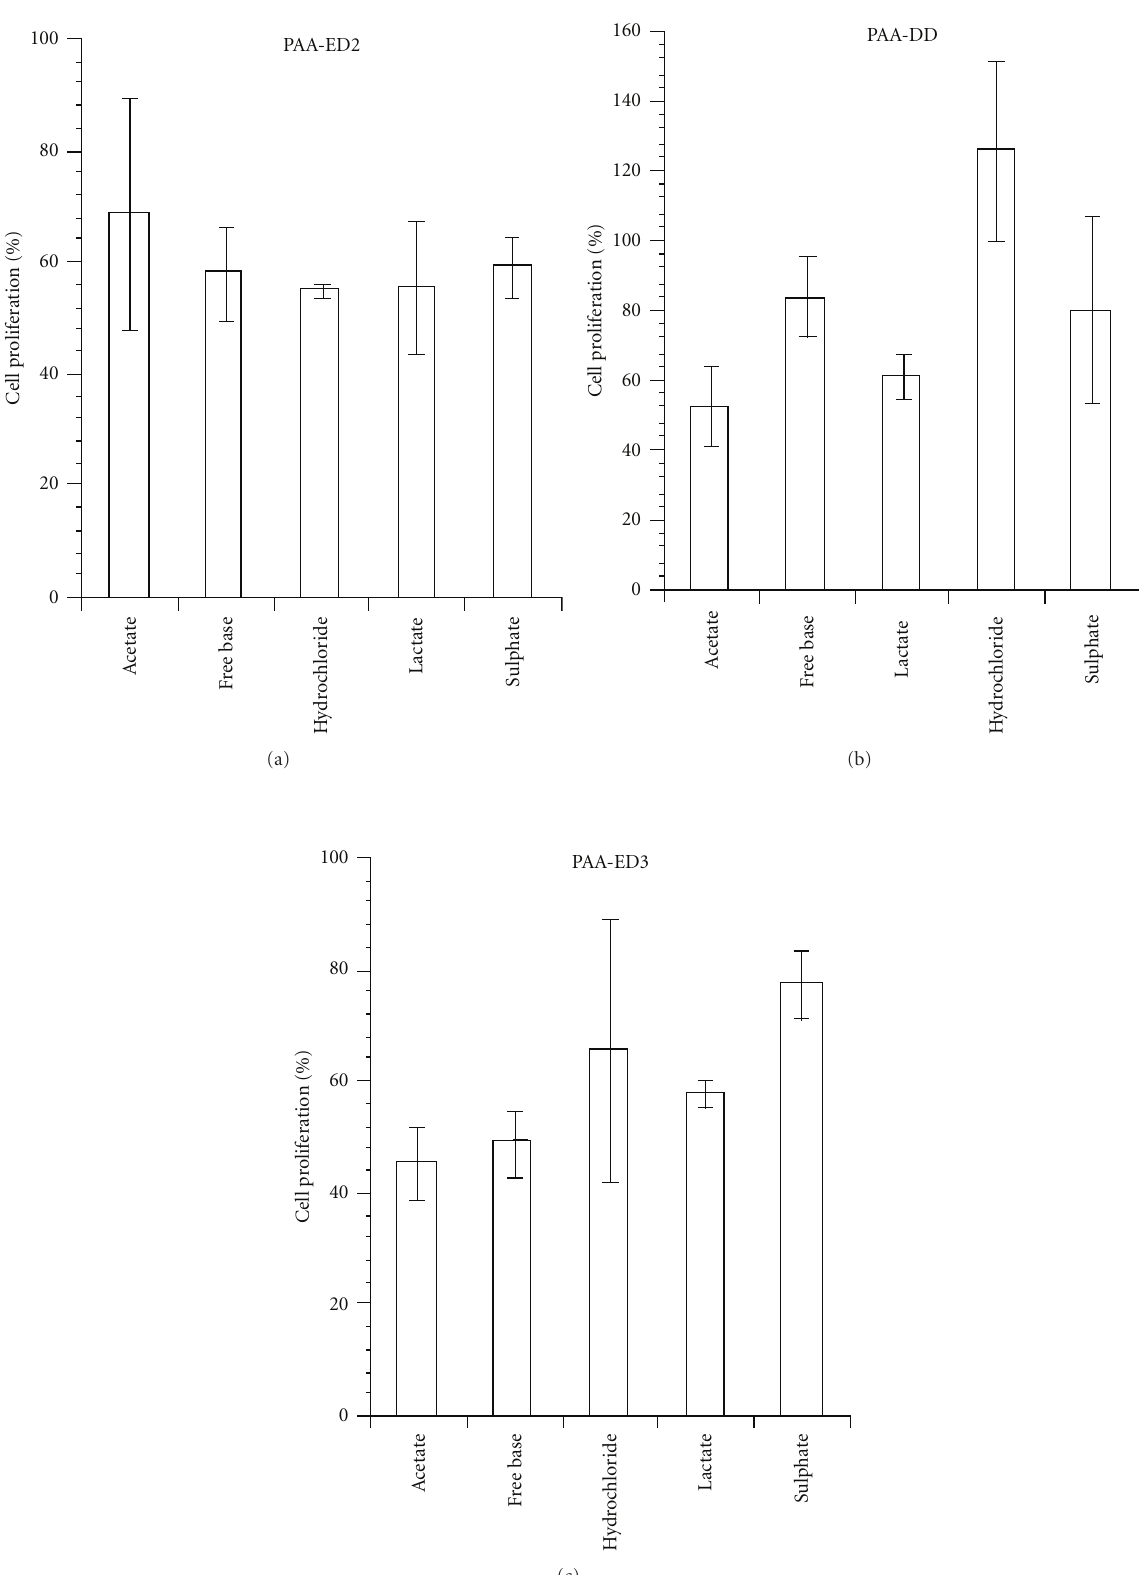
Figure 2: Results of the cytotoxicity tests of PAA-ED2, PAA-DD and PAA-ED3 hydrogels, as free base and ammonium salts, carried out on fibroblast cells by means of the direct contact method